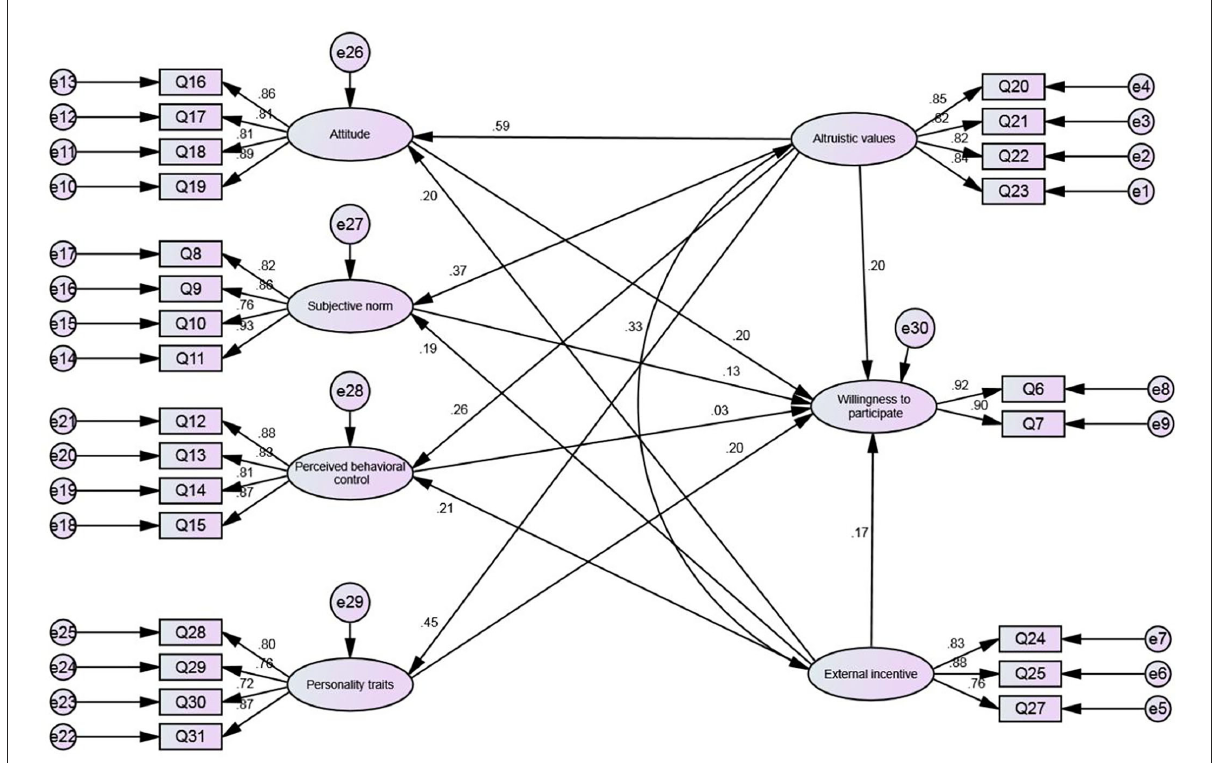
FIGURE1 Path diagram of willingness to participate in floating population health volunteer services.